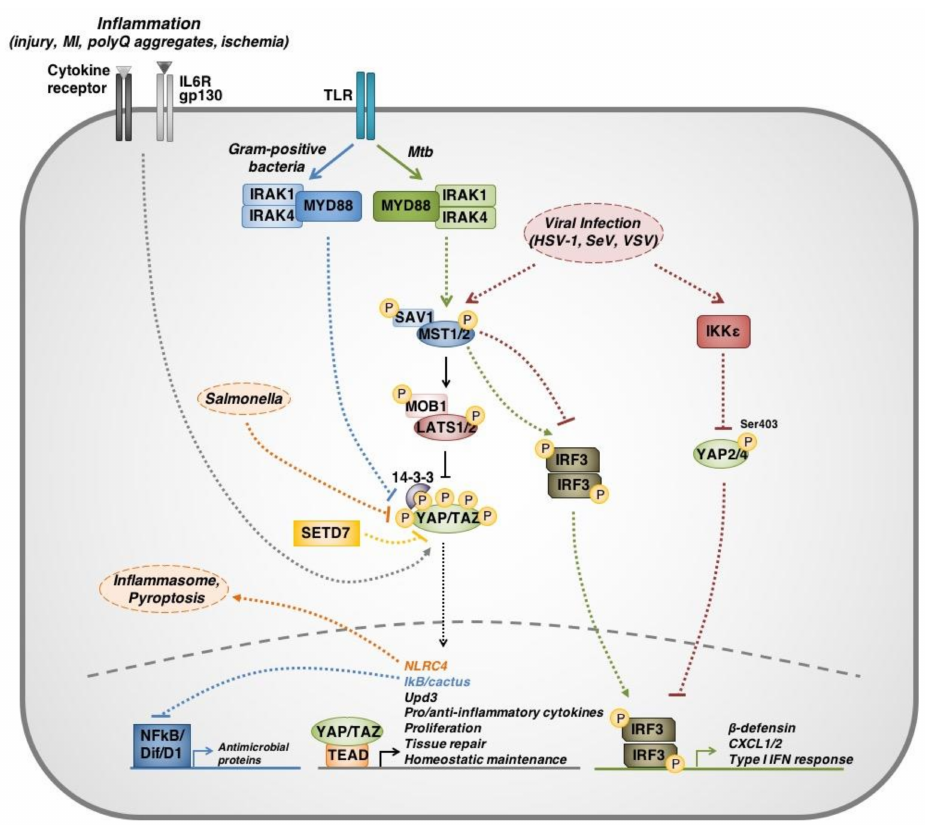
Figure 3. Overview of Hippo signaling immunomodulatory functions. Hippo pathway components participate in a number of both canonical and non-canonical signaling mechanisms that regulate, or are regulated by, immune responses and immune challenges. (1) Through TLR signaling, different stimuli have been shown to trigger different signal transduction cascades. Gram-positive bacteria have been shown to suppress YAP/TAZ transcriptional activity, which upregulates NFkB transcriptional activity through IkB/cactus and expression of antimicrobial proteins. On the other hand, Mycobcterium tuberculosis (Mtb) pathogenesis is associated with non-canonical MST1-IRF3 signaling to induce an antipathogenic response, independent of LATS1/2 and YAP/TAZ. (2) Inflammation as a result of insults (myocardial infarction, neuronal polyglutamine aggregates, or ischemia) can upregulate YAP/TAZ signaling through a number of mechanisms that are involved in augmenting tissue repair and mitigating deleterious cytotoxic inflammation. (3) Viral infection (herpes simplex virus (HSV-1), Sendai virus (SeV), vesicular stomatitis virus (VSV)) has been associated with both inducing and suppressing antiviral immunity. This mechanism involves suppression of IRF3 signaling by non-canonical MST1 function to dampen type I interferon response, or phosphorylation at Ser403 and degradation of YAP2/4 to relieve YAP-mediated suppression of antiviral response. (4) Salmonella infection has been shown to induce inflammasome assembly through NLRC4 in macrophages. In B cells however, Salmonella infection inhibits YAP/TAZ transcriptional activity, therefore reducing expression of Nod-like receptor C4 (NLRC4) and inhibiting pyroptosis, ultimately enhancing Salmonella survival within B cells. (5) SETD7 suppresses YAP/TAZ function in the midgut. Parasitic infection by helminths has been shown to reduce SETD7 expression, thereby relieving YAP/TAZ inhibition and accelerating enterocyte/enteroblast proliferation to enhance helminthic clearance. Solid lines represent direct interactions. Dotted lines represent mechanisms that are indirect or have not been fully